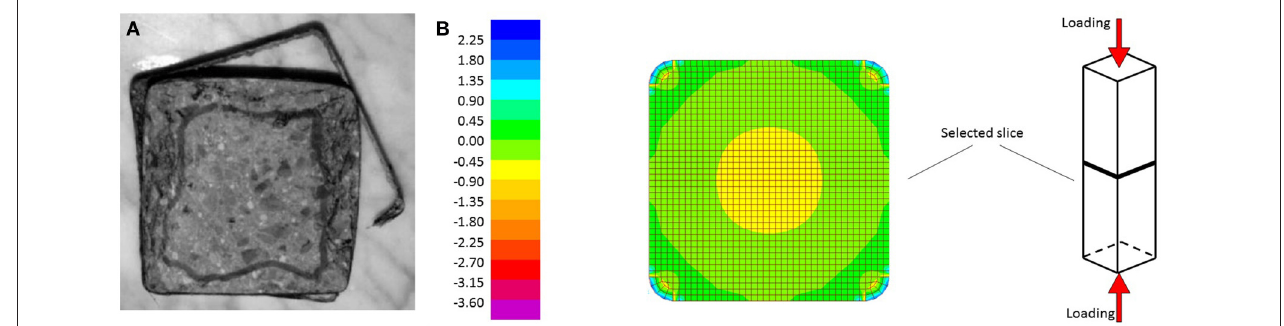
FIGURE 3 | Confining stresses in a quartile of a square section 200 not